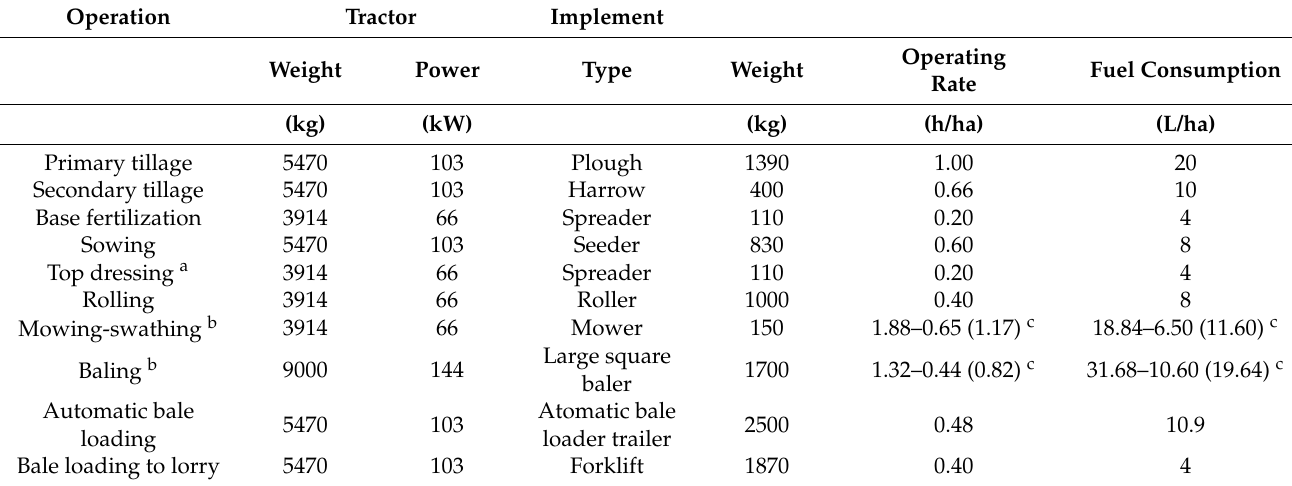
Table 2. Field operations performed for rye cultivation.